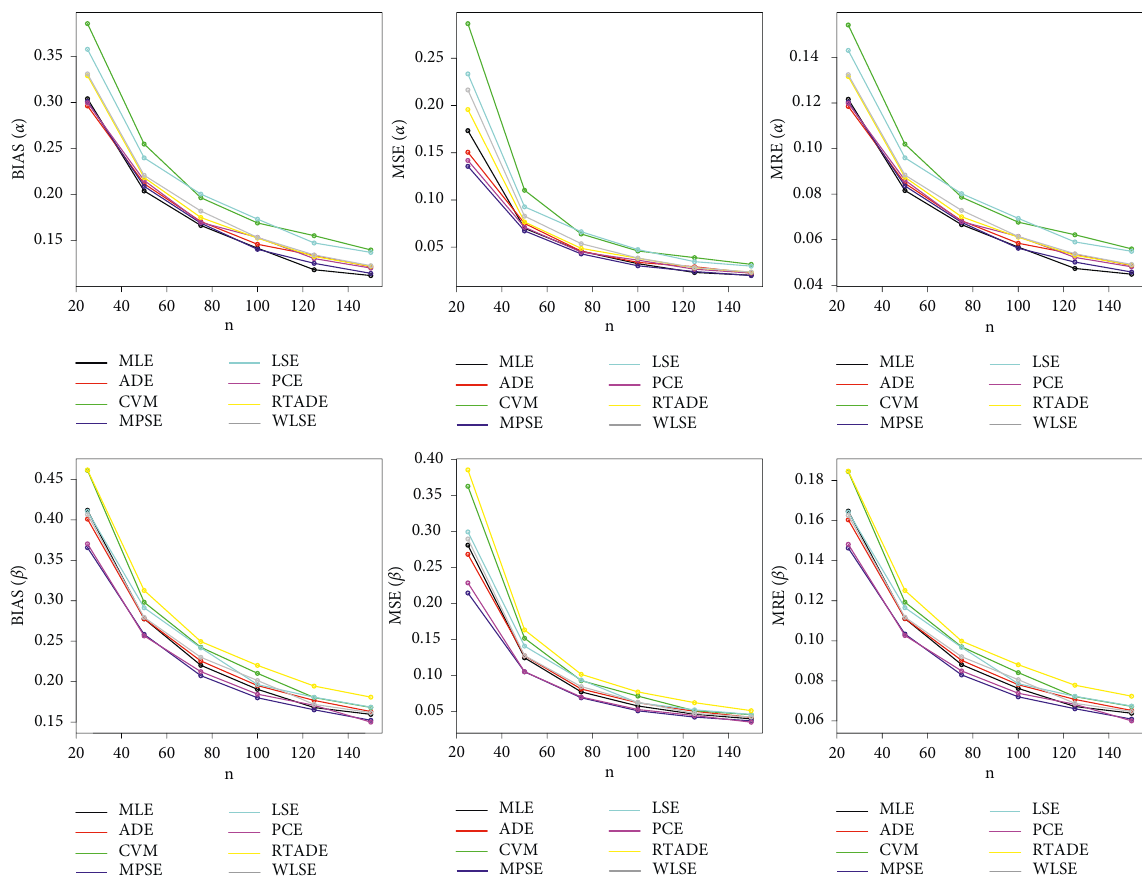
Figure 6: Graphical representation of BIAS, MSE, and MRE values in Table